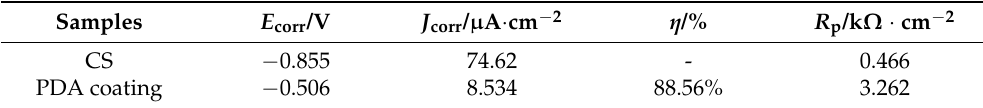
Figure 6. Potentiodynamic polarization curves of carbon steel (CS) and PDA coating in 3.5 wt.% NaCl solution. Table 1. Corrosion parameters of carbon steel (CS) and PDA coating obtained by potentiodynamic polarization curves.